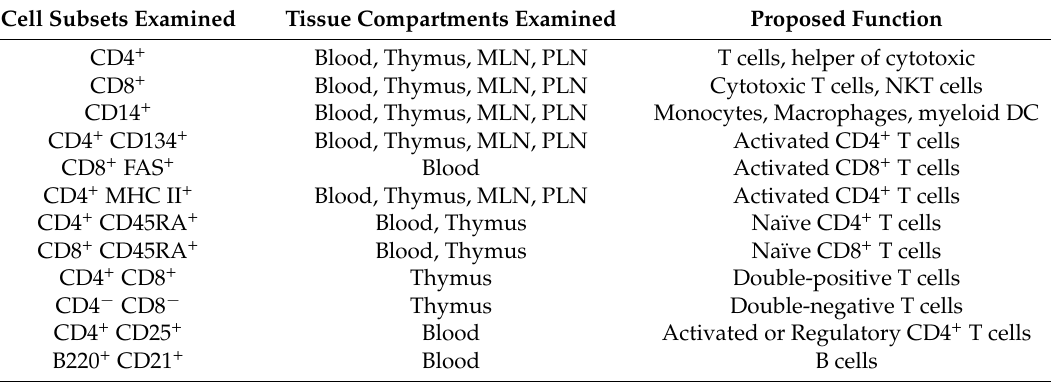
Table 2. Cell subsets examined in the different tissue compartments and the proposed function of each